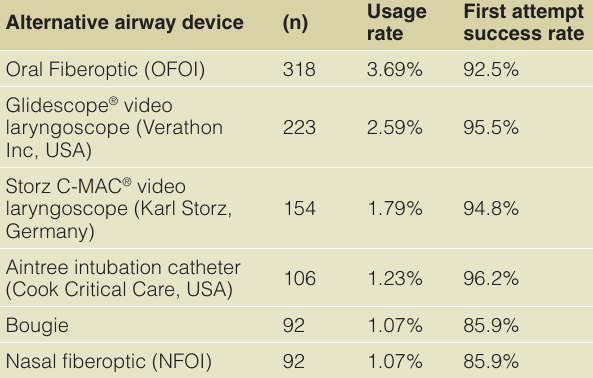
Table 2. Alternative airway device usage rates and first attempt success rates at our institution, Memorial Hermann Hospital – Texas Medical Center at Houston, TX, USA: n, number of responders that prefer the use of a particular device for the majority of cases; usage rate, the percentage of responders that prefer the use of a particular device for the majority of cases; first attempt success rate, number of cases in which successful intubation was achieved in the first